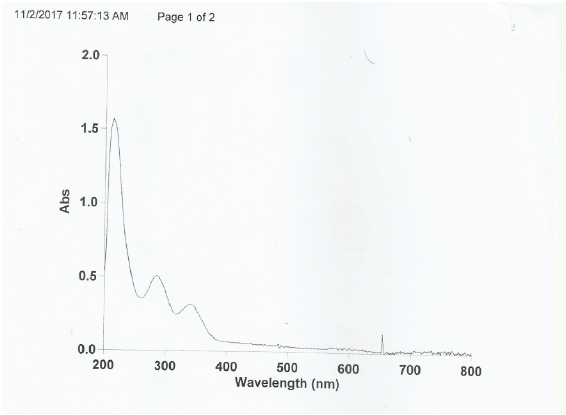
Figure 4: UV-Vis spectra of the complex Co(L 1 )(L 2 ) H 2 OCl].